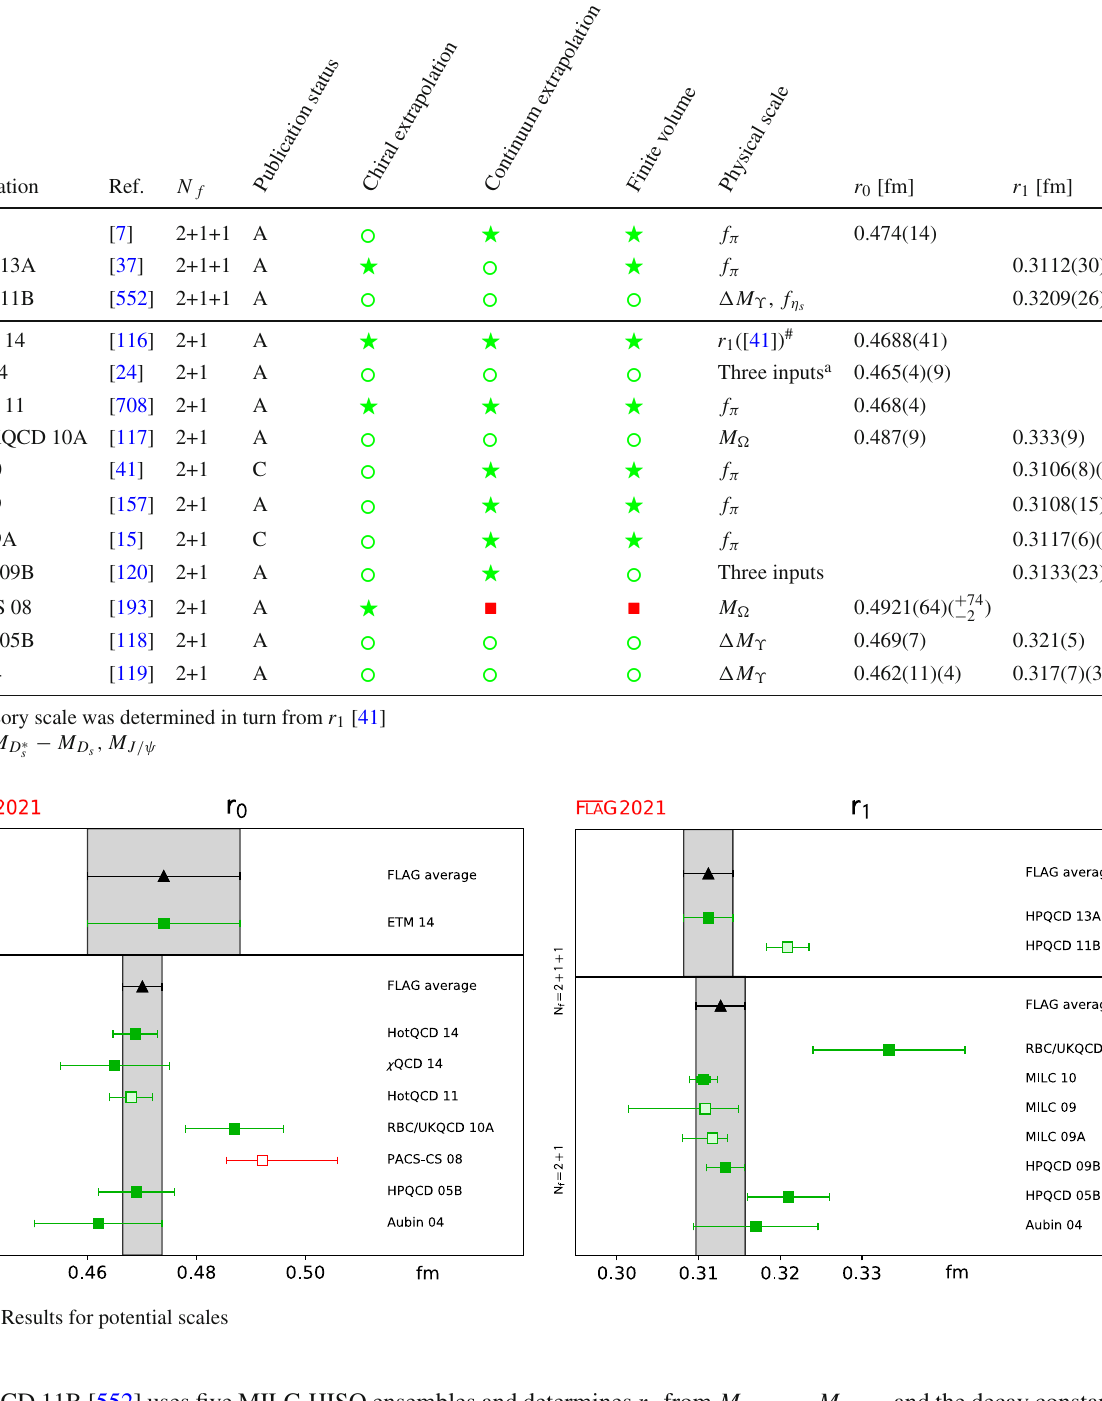
HPQCD 11B [552] uses five MILC-HISQ ensembles and determines r 1 from M ϒ( 2 s ) − M ϒ( 1 s ) and the decay constant f η s (see HPQCD 09B). The valence b quark is treated by NRQCD, while the light valence quarks have the HISQ discretization, identical to the sea quarks. = 2 + 1 domain-wall fermion gauge configurations χ QCD 14 [24] uses overlap fermions as valence quarks on N f and J /ψ as inputs, the strange and generated by the RBC/UKQCD collaboration [117]. Using the physical masses of D s , D ∗ s are determined as well as the scale r 0 charm quark masses and the decay constant f D s